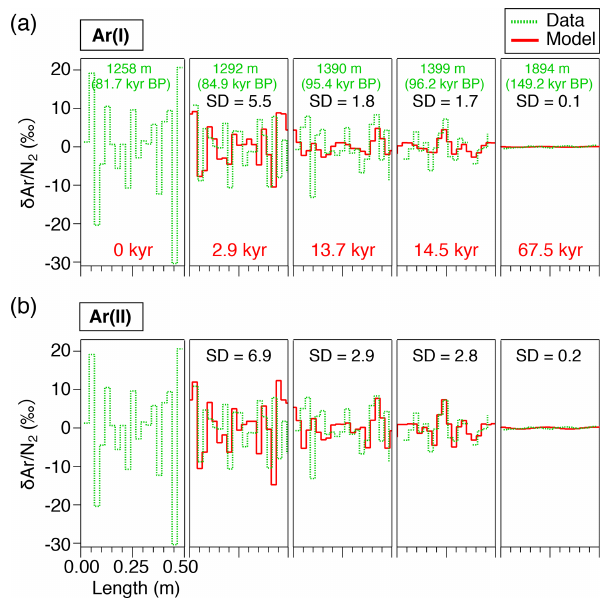
Figure 9. Same as Fig. 8 but for δ Ar / N 2